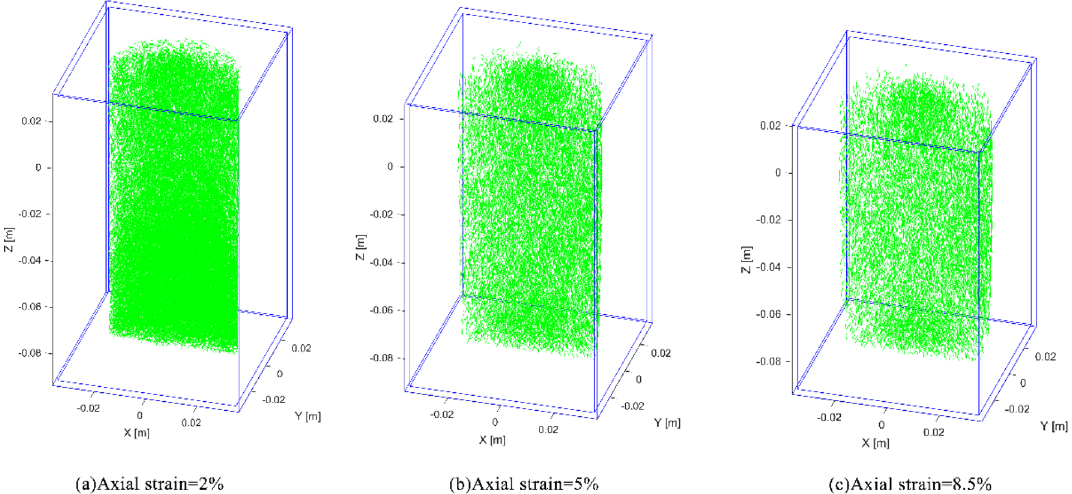
Figure 8. The micro connections of the model under 2 MPa confining pressure (segments indicate intact connections).